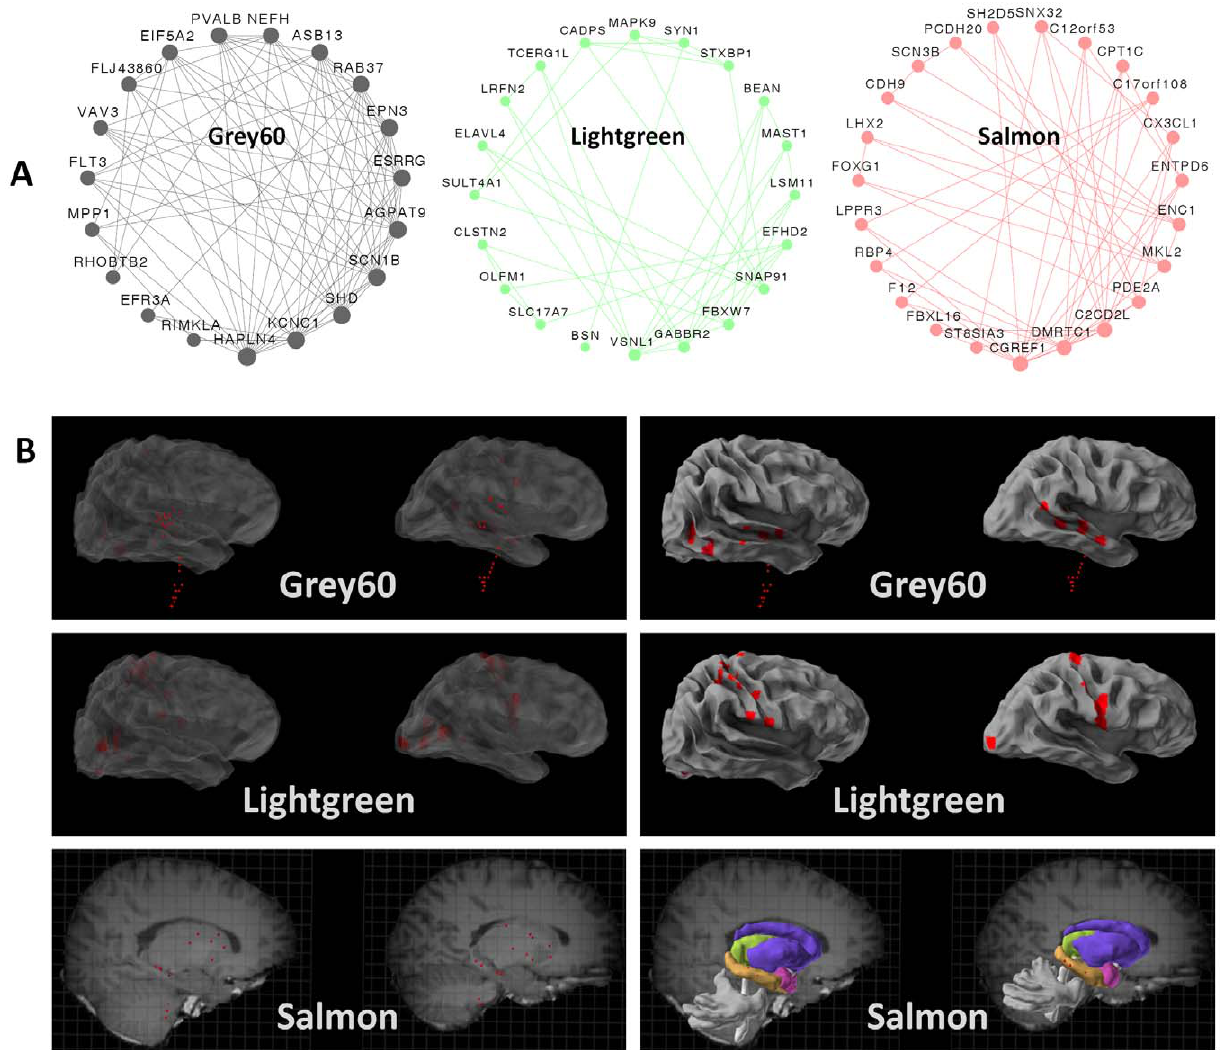
Figure 2. Modules correspond to specific neuronal sub-groups acting in specific regions. (A) For the three neuronal modules, the twenty genes with the most connections out of the top 150 connections in the module are illustrated. (B) For the three neuronal modules, the ten areas showing the highest expression of the module eigengene were visualized using Brain Explorer (http://www.brain-map.org). A superficial view of the brain is shown on the right, and an in-depth view is shown on the left. As some regions were available for only one of the two individuals, the regions are shown in both brains.